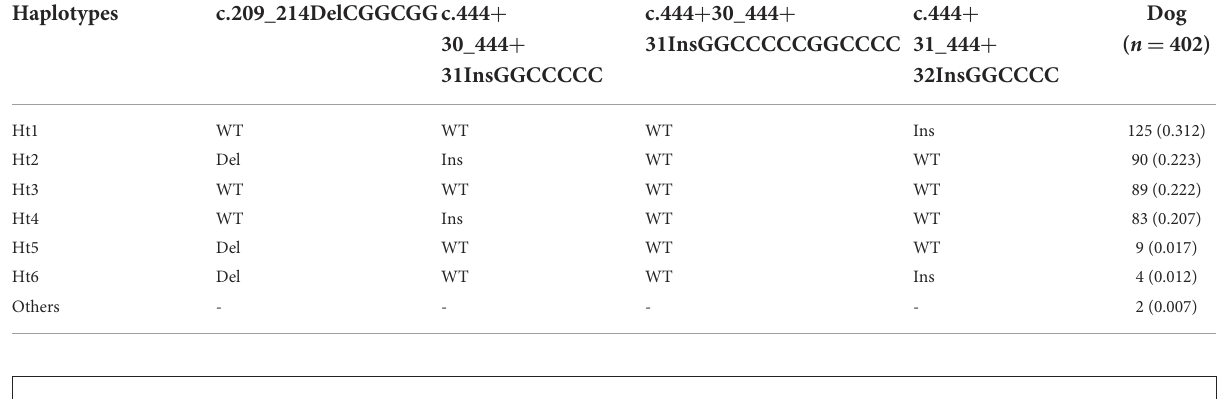
TABLE 3 Haplotype frequencies of 4 SPRN polymorphisms in dogs.